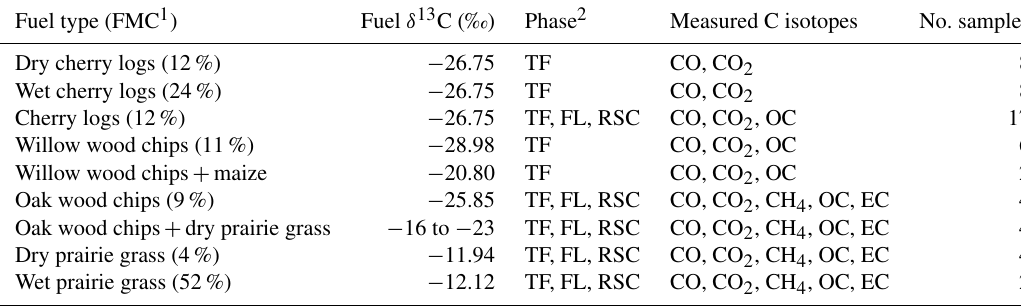
Table 2. Overview of the different laboratory